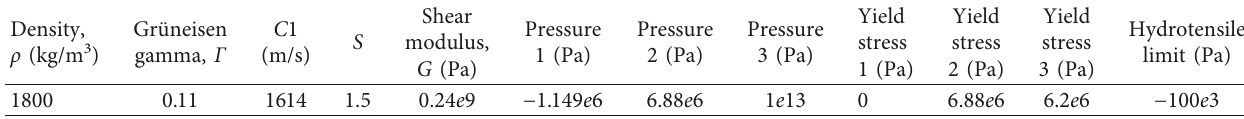
Table 5: Parameters of the soil model.